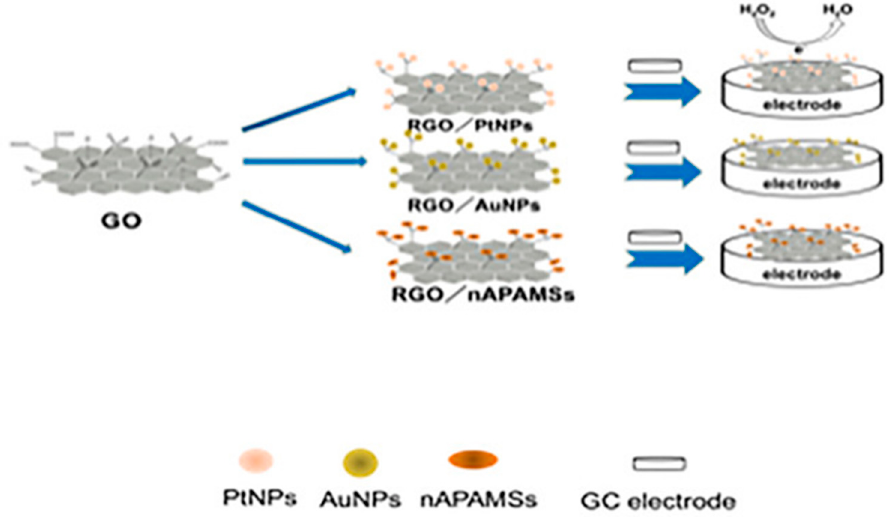
Figure 6. Scheme of an RGO/nAPAMSs fabricated H 2 O 2 sensor [57]. Copyright: American Chemical Society.